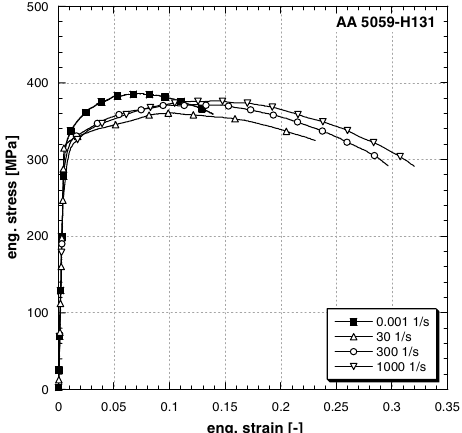
Fig. 4. Engineering stress and strain-rate versus time @ 300s − 1 and 1000s − 1 for AA 5059-H131.